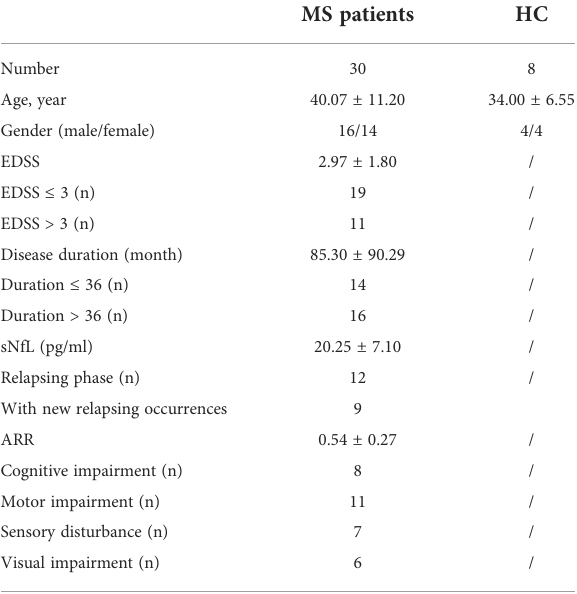
TABLE 1 Summary of MS patients and